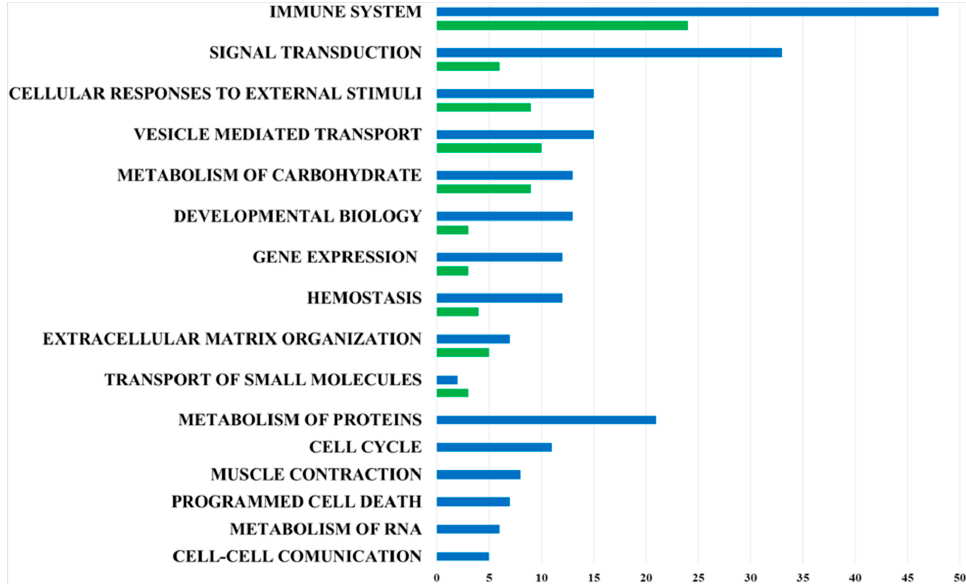
Figure 3. Bar diagram summarizing the functional classification of proteins present in the mDCs secretome (blue bars) and in the secretome of iDCs (green bars) achieved by Reactome Pathway Database analysis.